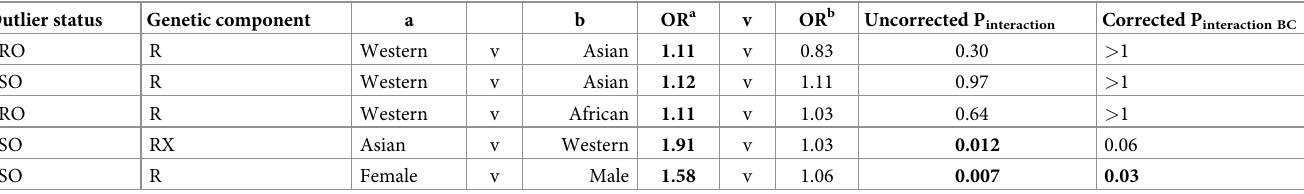
Table 4. Tests of